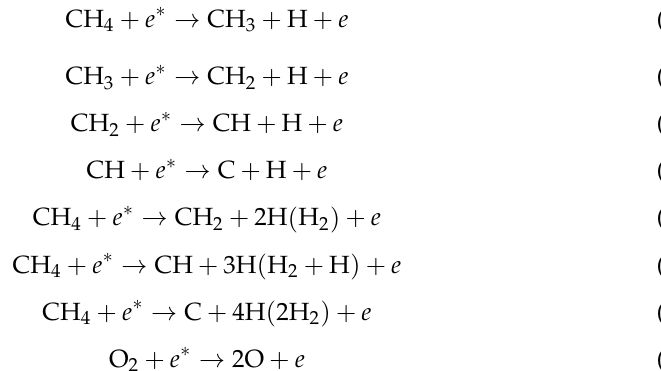
From the reactions listed above, it is clear that high-energy electrons (19.8 eV) gener- ated by collisions between metastable helium will activate methane and oxygen to cause their dissociation. This explains why the probe did not detect high-energy electrons of this kind (19.8 eV). As a result, the characteristic peak at 3.8 eV is derived from the following = 16 eV, E = 16 eV) reactions: ( E CH CH 2